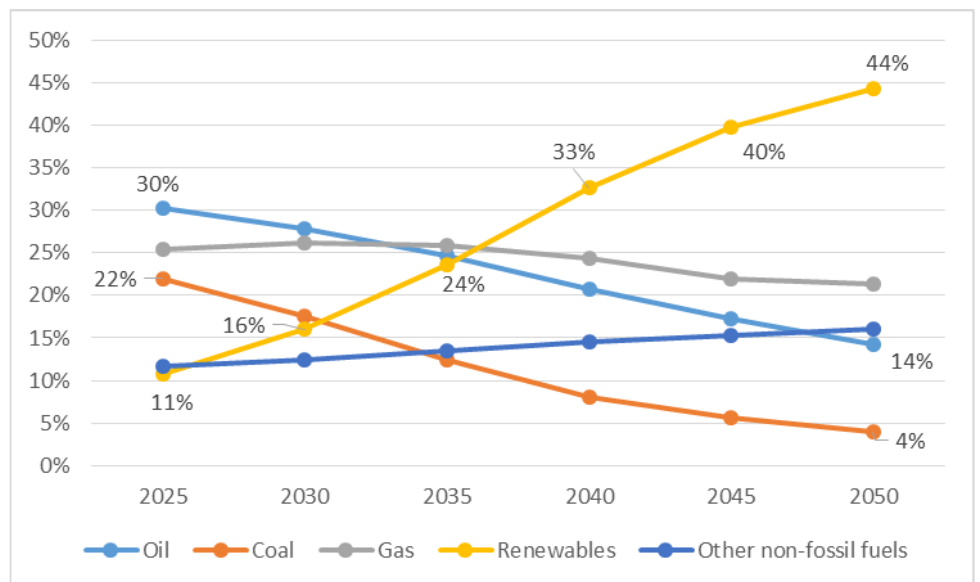
Figure 2. Global shares of primary energy in 2025 – 2050. Source: BP.